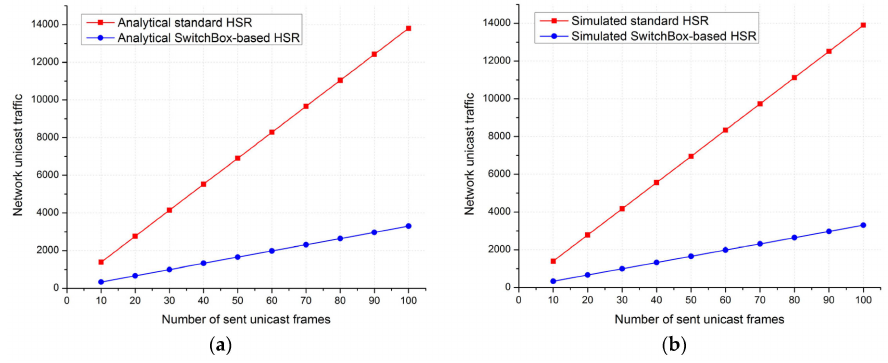
Figure 26. Comparison of the analytical and simulated unicast traffic performance. ( a ) Analytical unicast traffic; ( b ) Simulated unicast traffic.